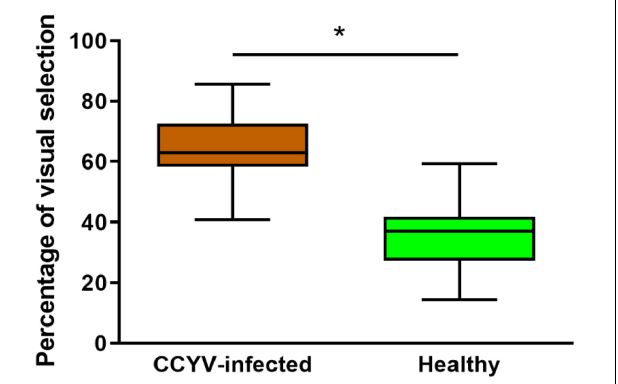
FIGURE 7 | Visual selection preference of B. tabaci between CCYV-infected and healthy plants. Data = mean ± standard error. One hundred adult insects were tested, and seven replicates were carried out. The percentage of B. tabaci was transferred with arcsine transformation for analyzing the difference using the one-sample t- test (hypothesis value: 50%, “*” <